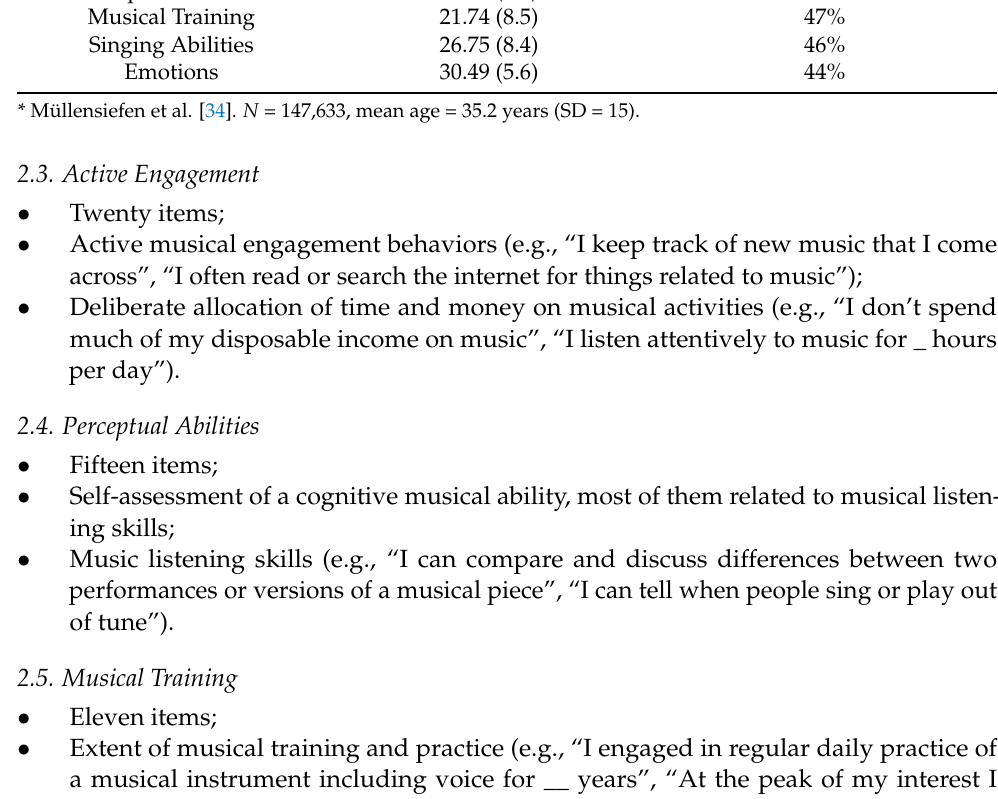
Table 1. Composite scores of the five Gold-MSI subscales for the present study and percentile scores relative to data norms of Gold-MSI [34]. Variable Mean (SD) (Present Study) Percentile Relative to Norms * Active Engagement 31.33 (9.3) 17% Perceptual Abilities 45.48 (8.4) 48% Musical Training 21.74